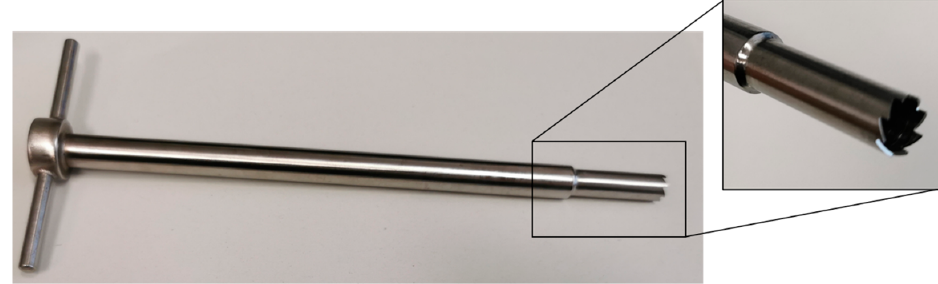
Figure 2. Trephine hand drill used for harvesting of trabecular bone cylinders.